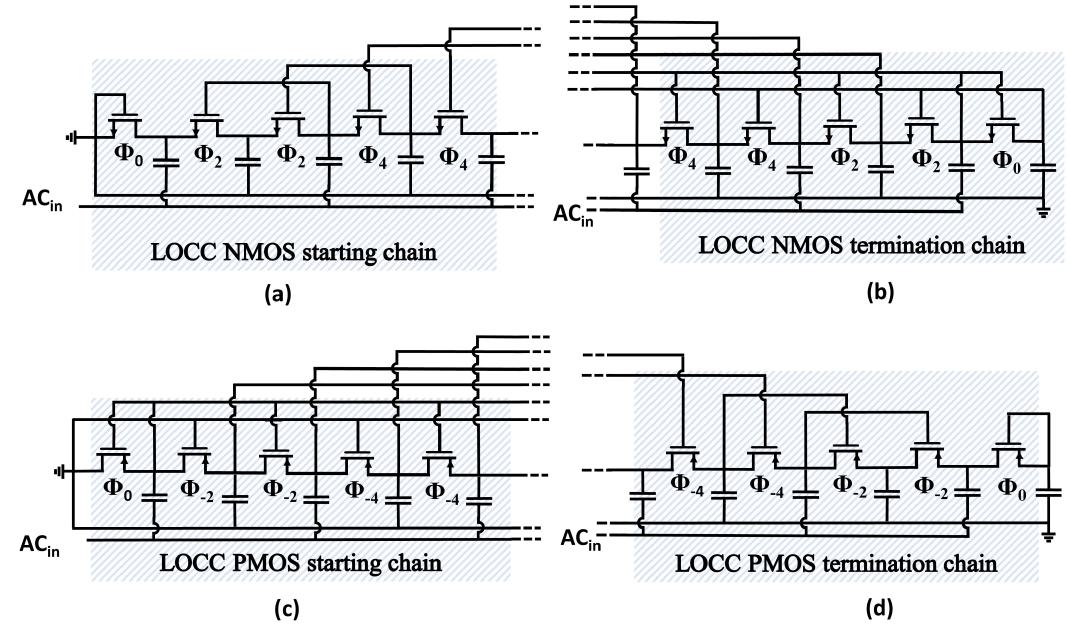
Figure 10. Circuit schematic of the proposed threshold-reduction technique implemented employing ( a ) an NMOS starting chain; ( b ) an NMOS termination chain; ( c ) a PMOS starting chain; and ( d ) a PMOS termination chain. LOCC: lower-order compensation chain.